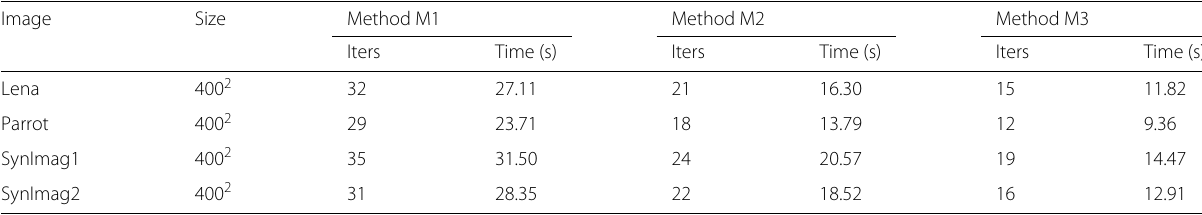
Table 3 Comparison of methods M1, M2, and proposed method M3 in terms of number of iterations (Iters) and CPU-time (Time) in seconds